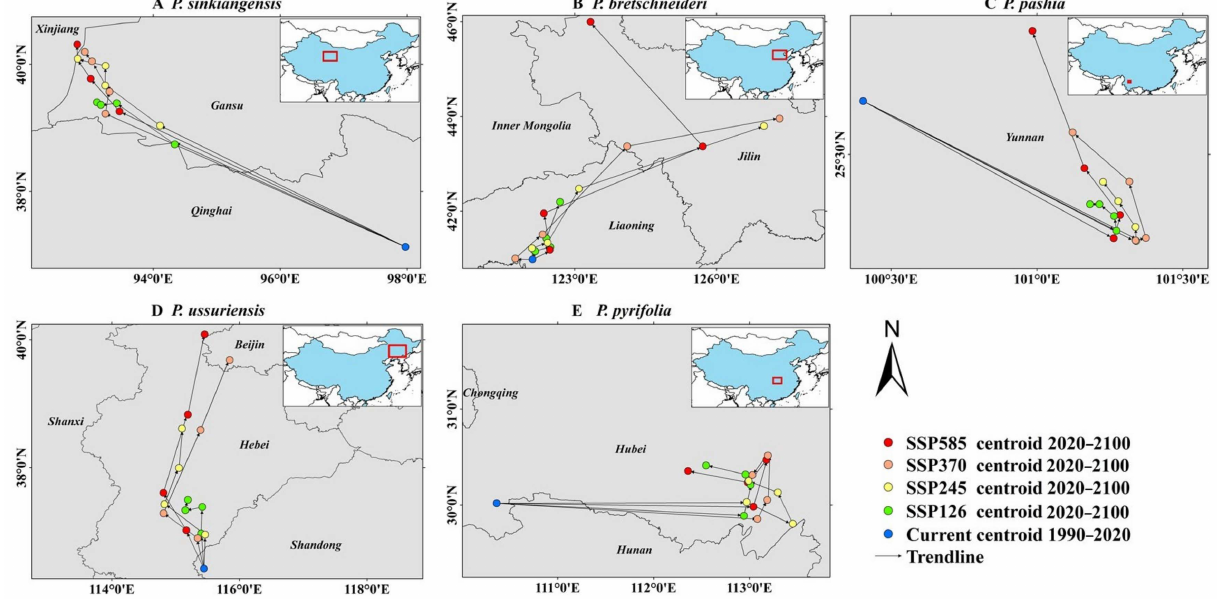
Figure 7. The centroid shift map of the climate-suitable areas for different species of ( A ) P.sinkiangensis , ( B ) P.bretschneideri , ( C ) P.pashia , ( D ) P.ussuriensis and ( E ) P. pyrifolia